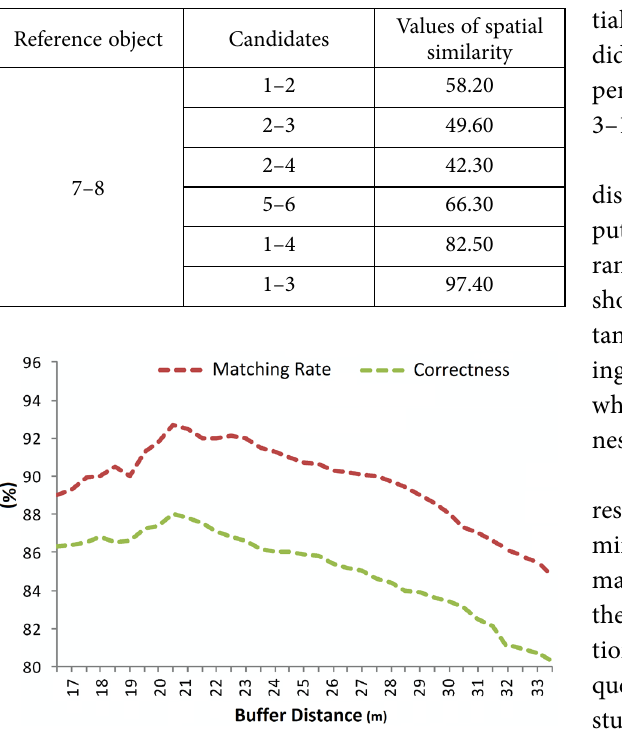
Table 4. Spatial similarity values of candidates